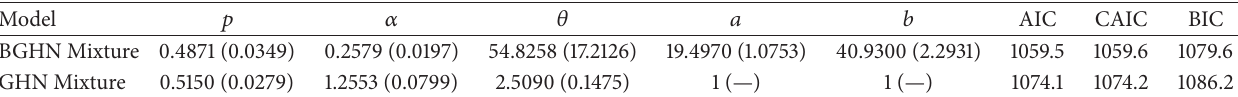
Table 5: MLEs of the model parameters for the melanoma data, the corresponding SEs (given in parentheses), and the AIC, CAIC, and BIC statistics.